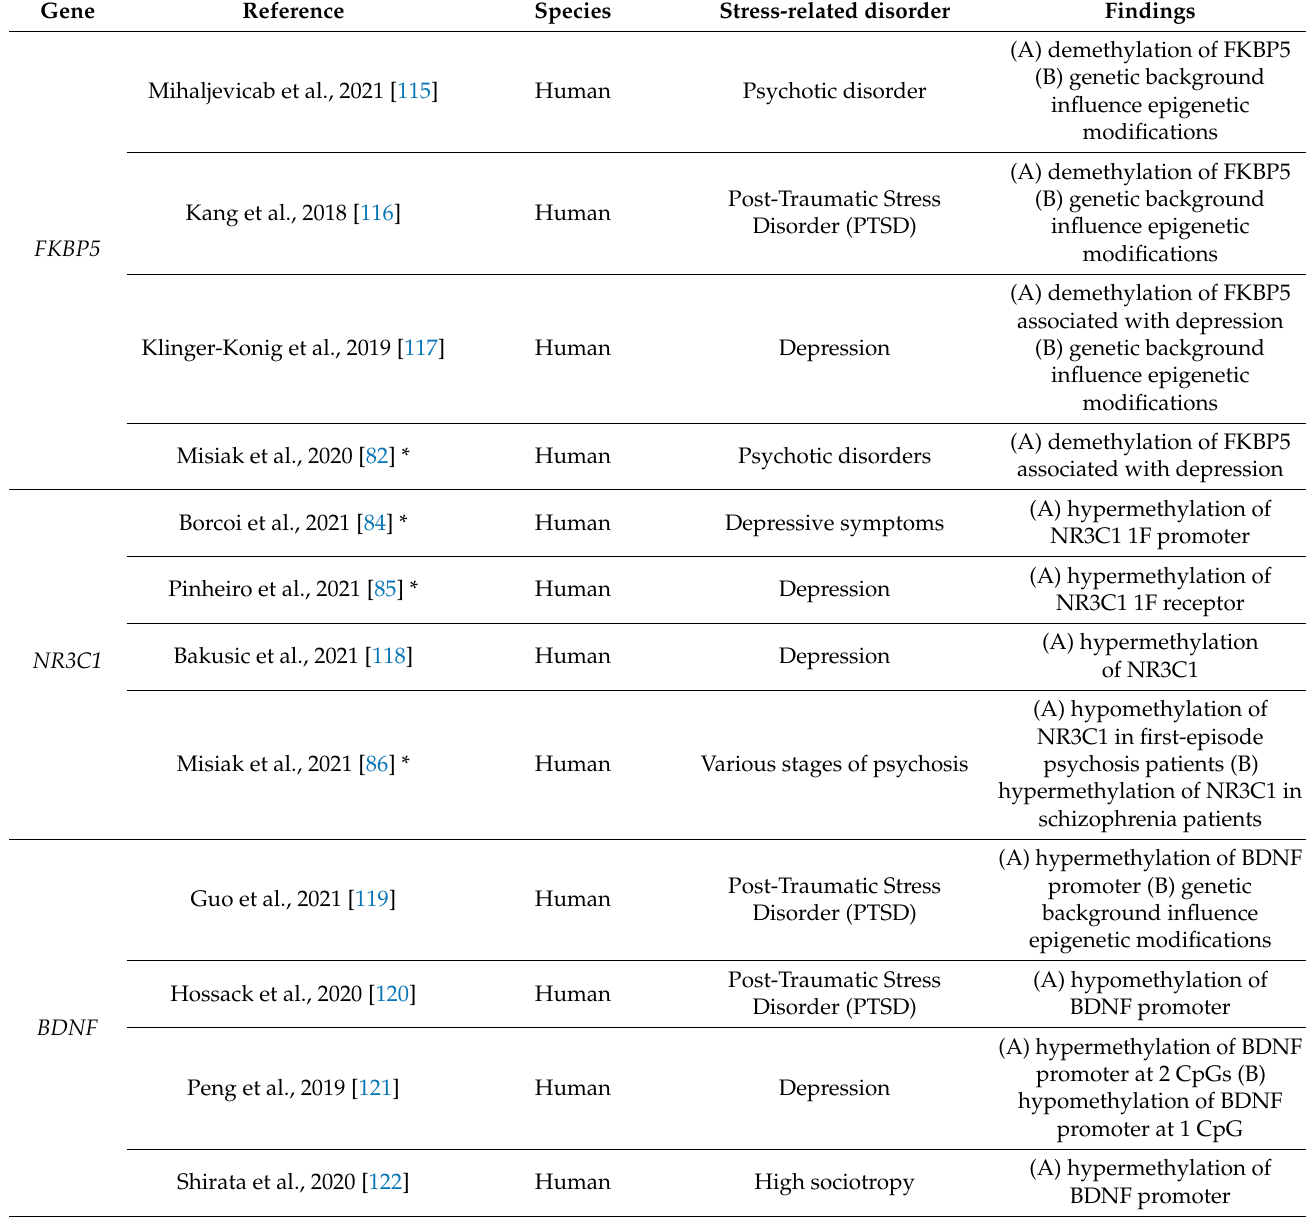
Table 2. Summary of the most recent findings about epigenetic modifications in stress-related disorders.